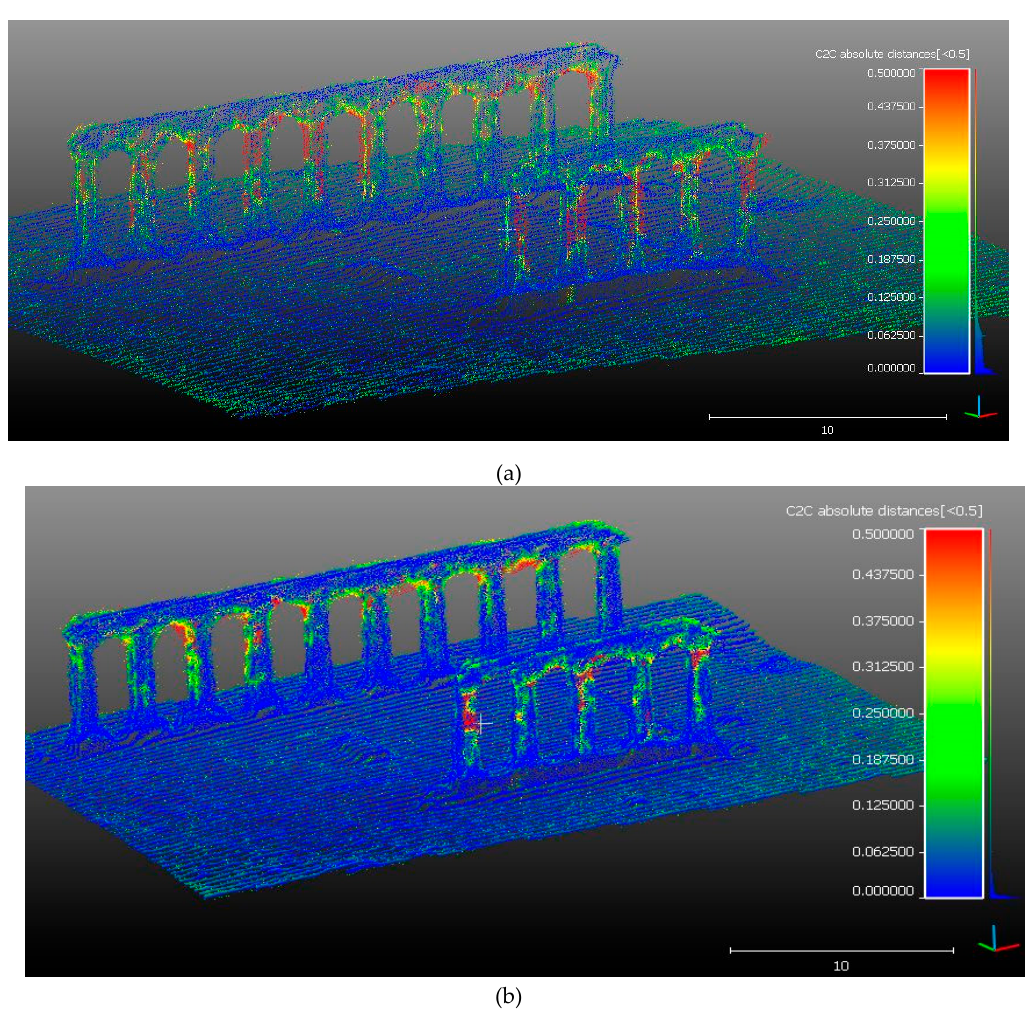
Figure 6. Comparison of point clouds (JPEG12) elaborated by Agisoft Metashape and 3DF Zephir: ( a ) low quality and ( b ) medium quality.